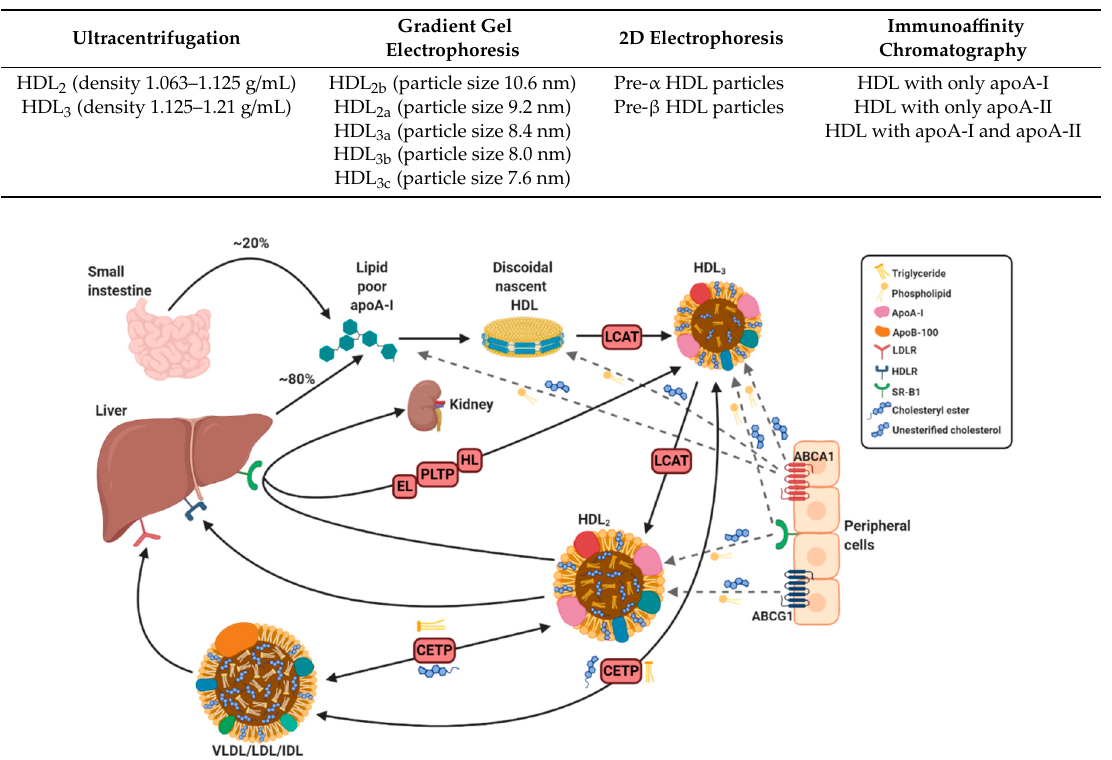
Figure 1. Simplified overview of HDL synthesis and metabolism. The liver and intestines produce apoA-I which becomes discoidal nascent HDL after interaction with ATP-binding cassette transporter A1 (ABCA1). Lipidation of discoidal nascent HDL with unesterified cholesterol and phospholipids via ABCA1, ABCG1, and scavenger receptor B type 1 (SR-B1) and cholesterol esterification via lecithin-cholesterol acyltransferase (LCAT) produces spherical HDL 3 and further lipidation results in HDL 2 (only representative cross sections shown). Cholesterol is transported to the liver directly from HDL 2 via a not yet identified HDL receptor (HDLR) or through binding with SR-B1 (to be excreted by kidneys) or indirectly via interaction of very-low-density lipoprotein (VLDL), low-density lipoprotein (LDL), and intermediate-density lipoprotein (IDL) with LDL receptor (LDLR) following uptake of cholesterol and triglycerides from HDL 2 , which is facilitated by cholesterol ester transfer protein (CETP). Recycling of HDL 2 occurs by the remodeling into lipid-poor and denser HDL 3 catalyzed by endothelial lipase (EL), hepatic lipase (HL), and phospholipid transfer protein (PLTP), which can once again undergo further lipidation. Solid arrows refer to specific steps in HDL metabolism and maturation, while dotted arrows reflect the transfer of triglycerides and unesterified cholesterol from peripheral cells to specific particles by interaction with displayed receptors.